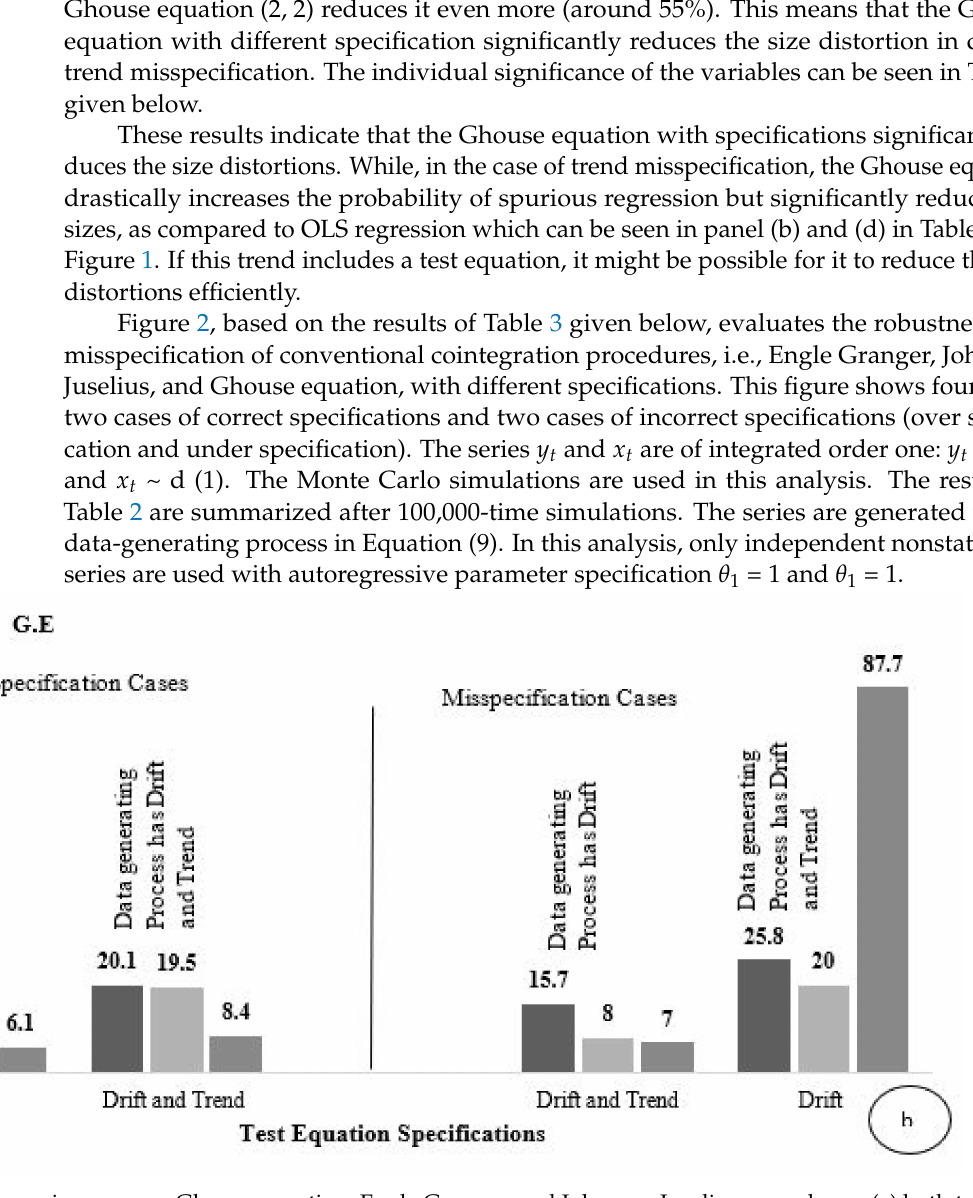
Figure 2. The size comparison among Ghouse equation, Engle Granger, and Johansen Juselius procedures. ( a ) both test equation and data-generating process take the drift term; ( b ) the test equation takes drift and trend, the data generation process takes